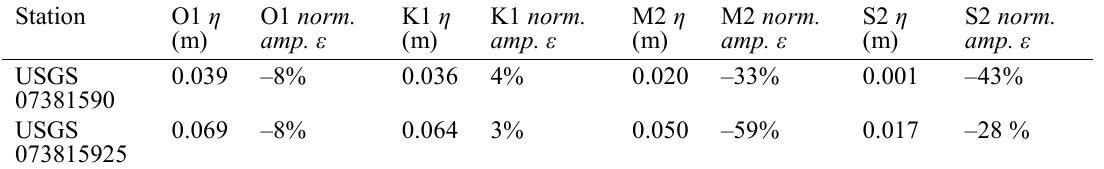
Table 1 Tidal constituent calibration results at water level gauge locations. Station